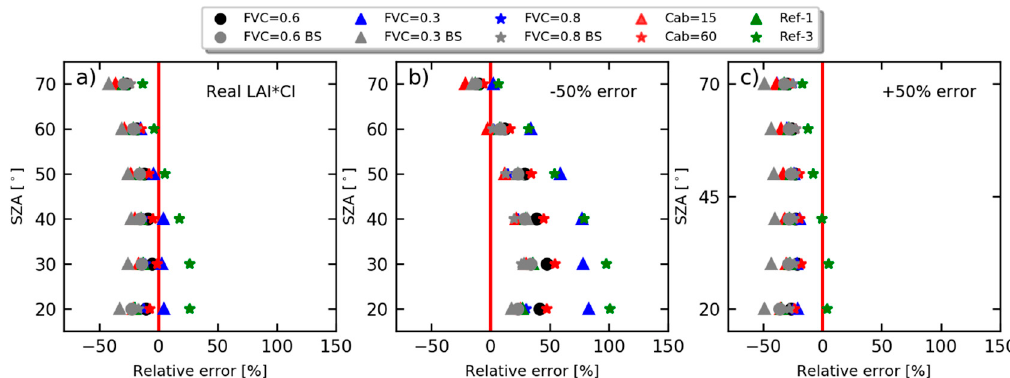
Figure 6. Comparison of SIF escape probability estimated by SIT and using leaf area index (LAI) and clumping index (CI) as input for the estimation of canopy interceptance (i.e., f esc thatweresimulatedbyDART(i.e., f esc errors of LAI*CI were introduced to plot ( b , c ). Relative error was calculated as ( f esc